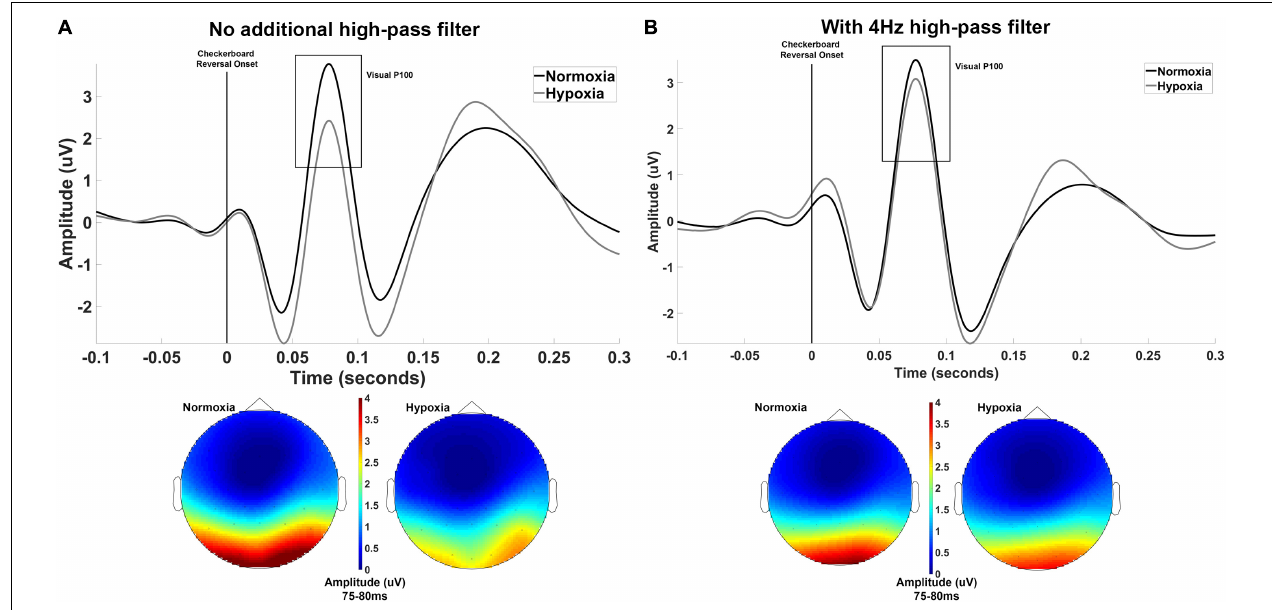
FIGURE 2 | (A) Grand averaged waveforms averaged across electrodes Oz, O1, and O2 shown separately for normoxia and hypoxia with no additional high-pass filter. Also shown are scalp maps illustrating grand averaged amplitude from 75 to 80 ms for normoxia and hypoxia separately. With no additional high-pass filter, these results indicate a significant reduction in the P100 amplitude under hypoxic compared to normoxic conditions. (B) The exact same data are shown with the inclusion of a 4 Hz high-pass filter to account for slow shifts in the EEG signal. This additional filter yielded a non-significant difference in P100 amplitude between hypoxia and normoxia